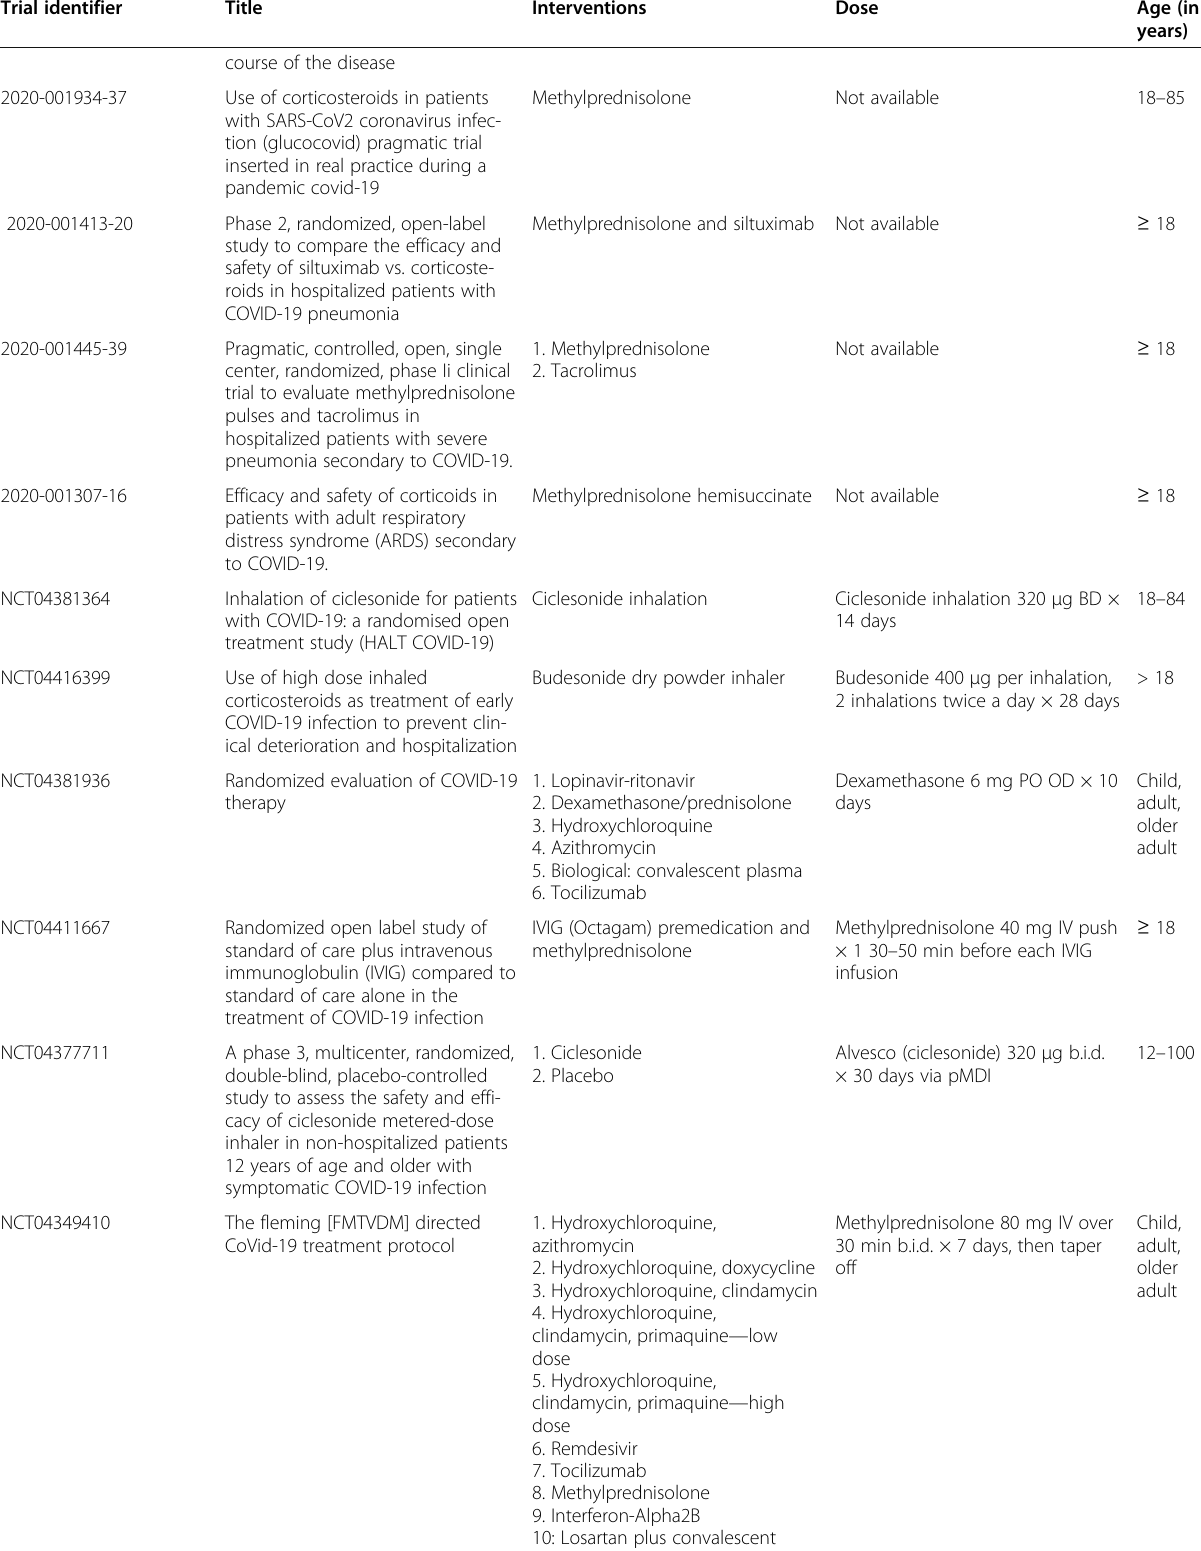
Table 3 Steroid treatment in patients with COVID-19 (Continued) Trial